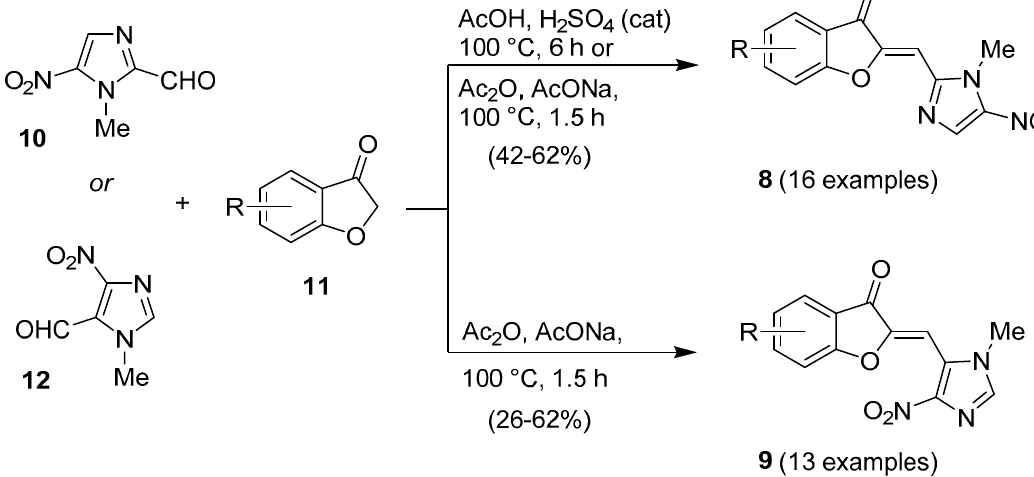
Figure 3. Structures and yields of some representative compounds 8 a nd 9 synthesised according to Scheme 2. Compounds 11 , which were key intermediates for the synthesis of hybrids 8 and 9 , were in turn prepared starting from salicylic acids 13 via the route shown in Scheme 3 that involved the ring closure of intermediates 14 in refluxing Ac 2 O/AcOH followed by hydrolysis of the resulting compounds 15 in a mixture of HCl/H 2 O/MeOH (1:10:40) under reflux for 1 h [26].